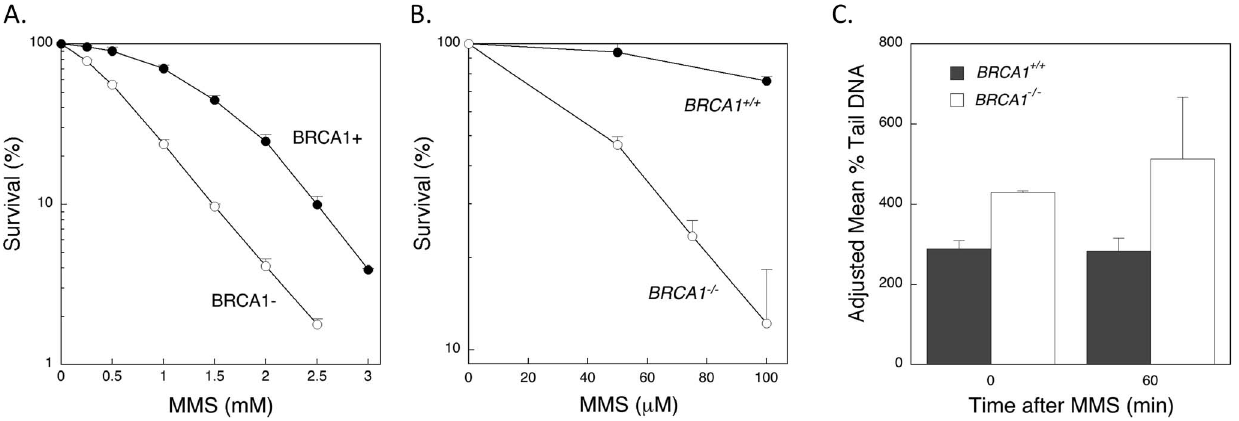
Figure 2. Characterization of MMS-induced DNA damage in human and DT40 BRCA1 cell lines. Experiments were conducted as described under ‘‘Materials and Methods’’. A. Human BRCA1 positive ( + ) and negative ( 2 ) cells were treated for 1 h with MMS as indicated, and survival was measured. B. Chicken DT40 BRCA1 + / + (wild-type) and BRCA1 2 / 2 cells were treated continuously with MMS, and survival was measured by clonogenic assay. Results with error bars represent the mean 6 SE of at least 3 independent experiments; other data points represent the mean of two experiments. C. DT40 BRCA1 + / + and BRCA1 2 / 2 cells were treated with 20 mM MMS for 20 min on ice and then subjected to the alkaline comet assay for measurement of strand breaks after 0 and 60 min repair. 100 cells were scored per slide, 2 slides per cell type and time, and migrated DNA was measured as the Mean % Tail DNA 6 SD of 2 replicate slides. Mean % Tail DNA was normalized to the untreated Mean % Tail DNA in the respective cell line. The difference between cell types in level of DNA damage was significant (p=0.003).